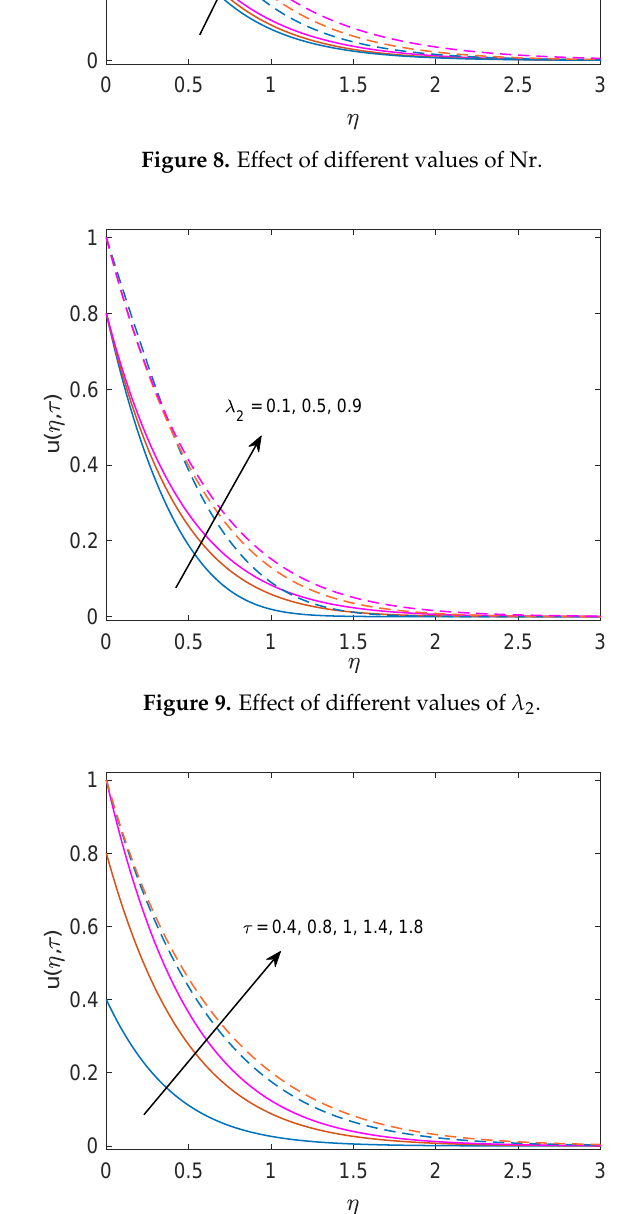
Figure 10. Effect of different values of τ